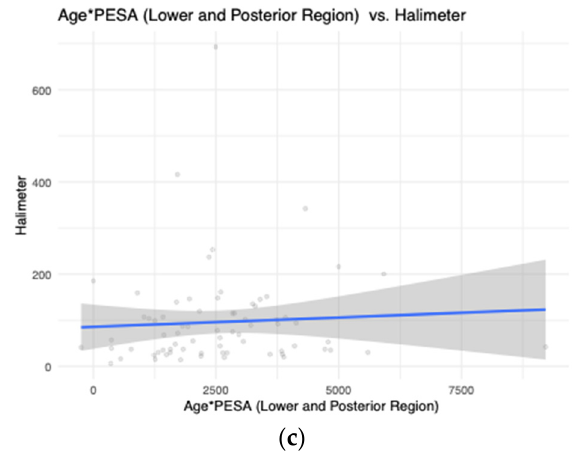
Figure 2. Graphical representation of PESA posterior-lower teeth and age towards the measurement of VSCs. ( a ) PESA (Lower and Posterior Region) vs Halimeter; ( b ) Age vs Halimeter; ( c ) Age*PESA (Lower and Posterior Region) vs Halimeter.